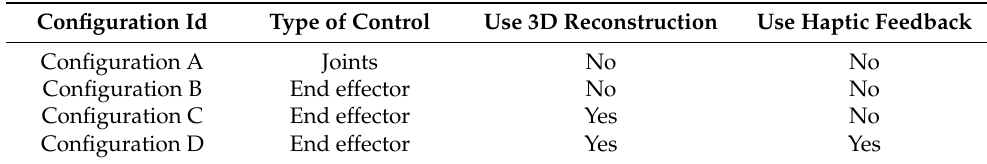
Table 1. Types of system’s configurations used in